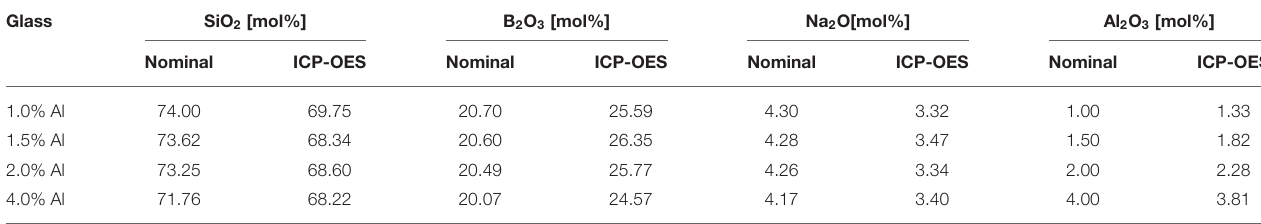
TABLE 1 | Nominal and measured compositions of the glasses under investigation.